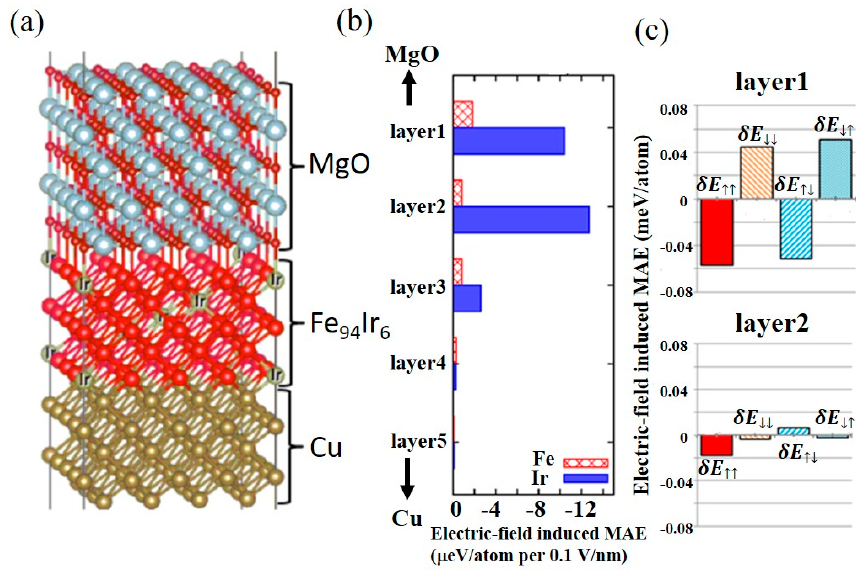
Figure 15. First principles calculations of the electric-field induced magnetic anisotropy energy change in an Ir-doped Fe/MgO system. ( a ) Supercell structure used for the calculation, consisting of MgO (5 ML)/FeIr (5 ML)/MgO (5 ML). ( b ) Atomic-resolved magnetic anisotropy energies (MAE) change induced by an electric-field of 0.1 V / nm in MgO. The Ir concentration was maintained at about 6% in the FeIr layer. ( c ) The electric-field induced MAE arising from second-order perturbation of the spin-orbit coupling for Ir atoms in layers 1 and 2. Reproduced from [35]. CC BY 4.0.